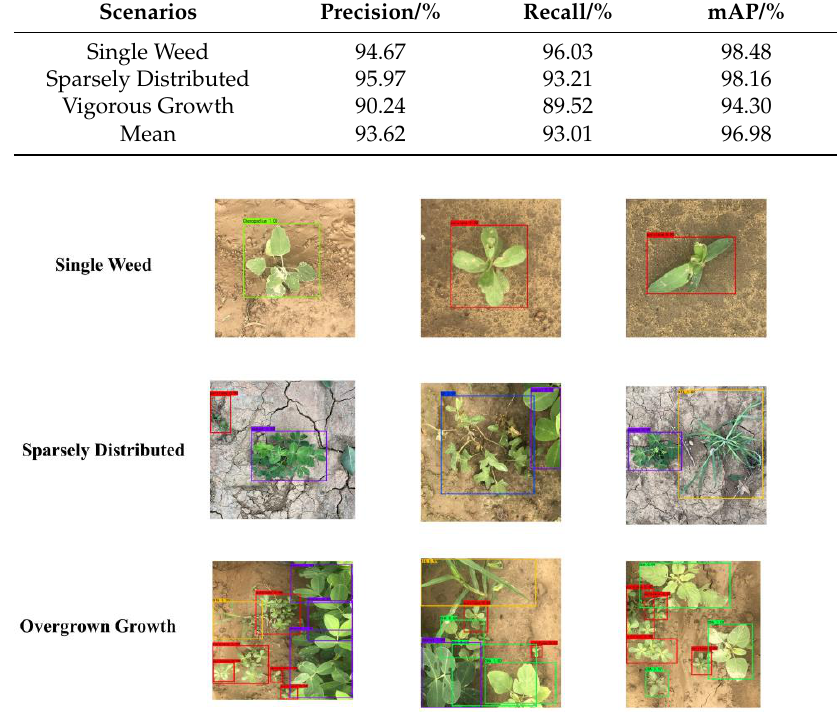
Figure 6. Effect of model recognition under different scenarios. Table 7. Performance comparison results of models in different scenarios.